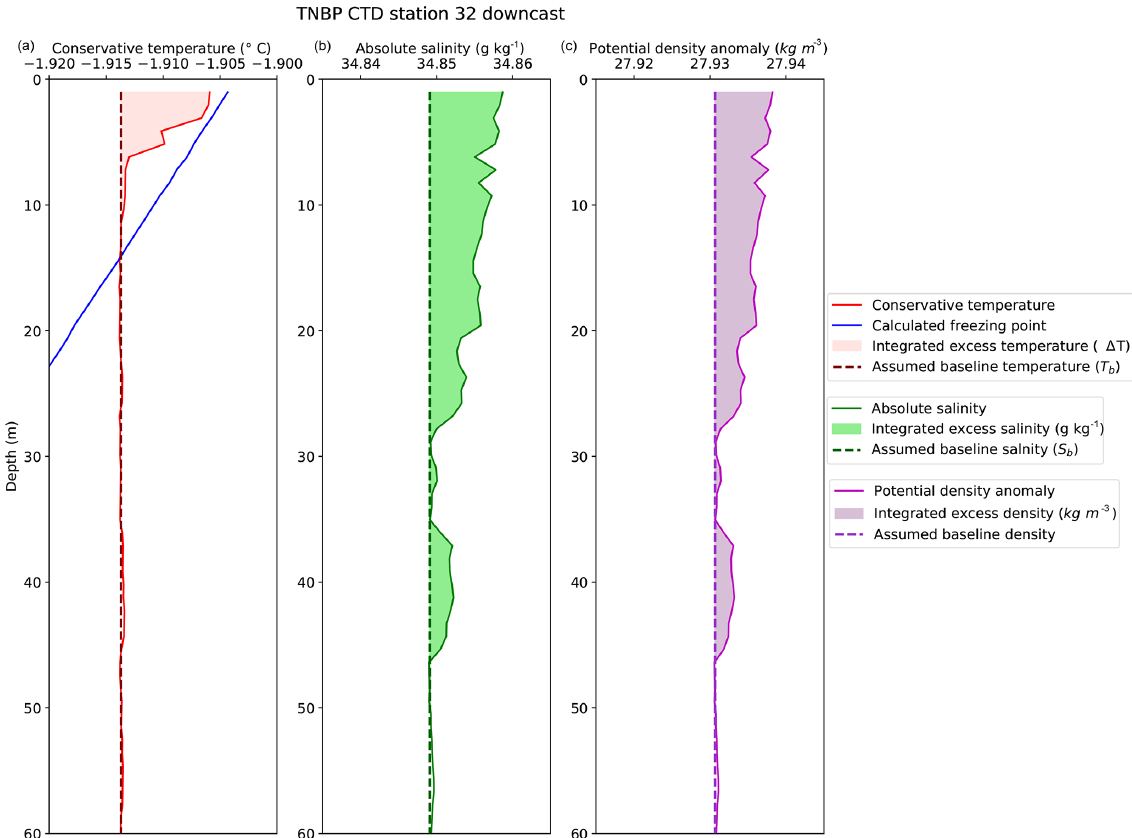
Figure 7. Conservative temperature, absolute salinity, and potential density anomaly for TNBP CTD Station 32, 9 May 2017. (a) Con- servative temperature profile showing the temperature anomaly, the selected baseline temperature (dashed line), and the integrated excess temperature (shaded area). (b) Absolute salinity profile showing the salinity anomaly, the selected baseline salinity (dashed line), and in- tegrated excess salinity (shaded area). (c) Potential density anomaly showing the selected baseline density (dashed) and the excess density instability